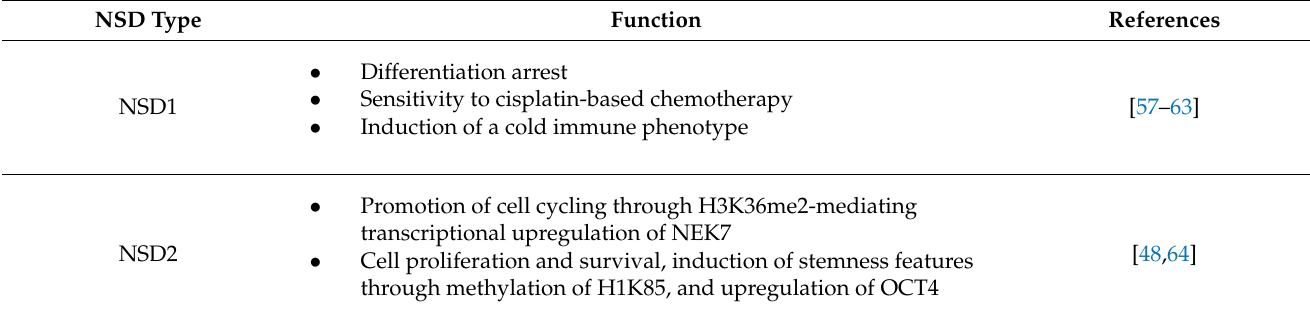
Table 2. Function of NSDs in HPV-negative